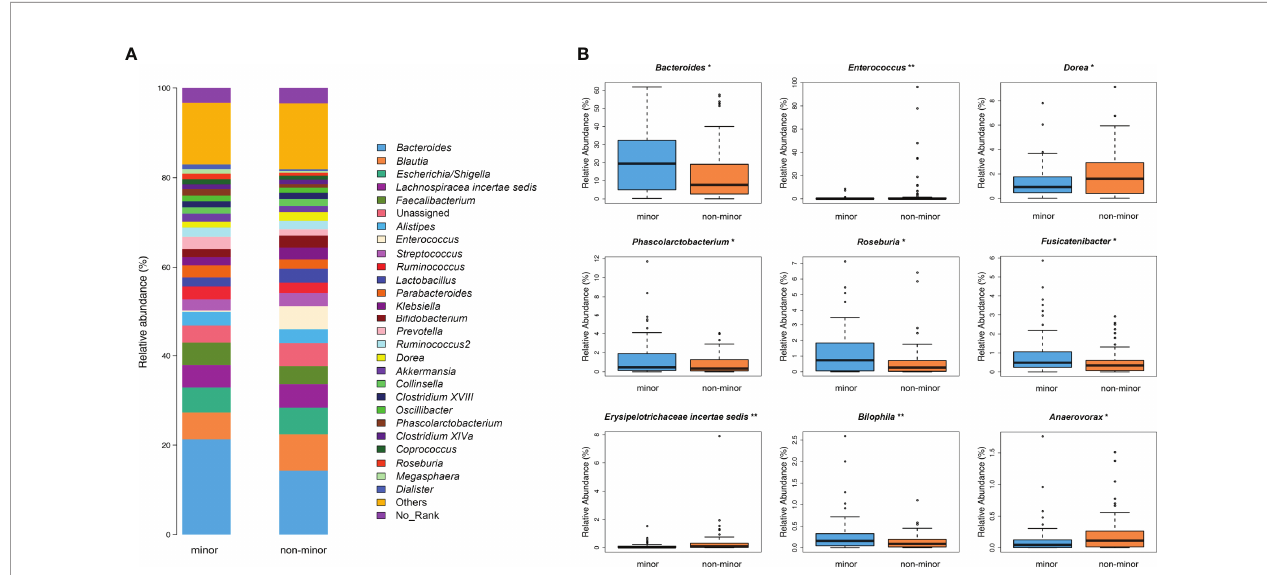
FIGURE 3 | Genus-level difference of microbial composition between minor stroke patients and non-minor stroke patients. (A) Taxonomic summary of the gut microbiota of minor stroke patients and non-minor stroke patients at the genus level. (B) Bacteria with signi fi cant differences between minor stroke patients (blue) and non-minor stroke patients (orange) at the genus level (Metastats analysis). Boxes represent the interquartile ranges, lines inside the boxes denote medians, and circles are outliers. *p < 0.05, **p < 0.01.